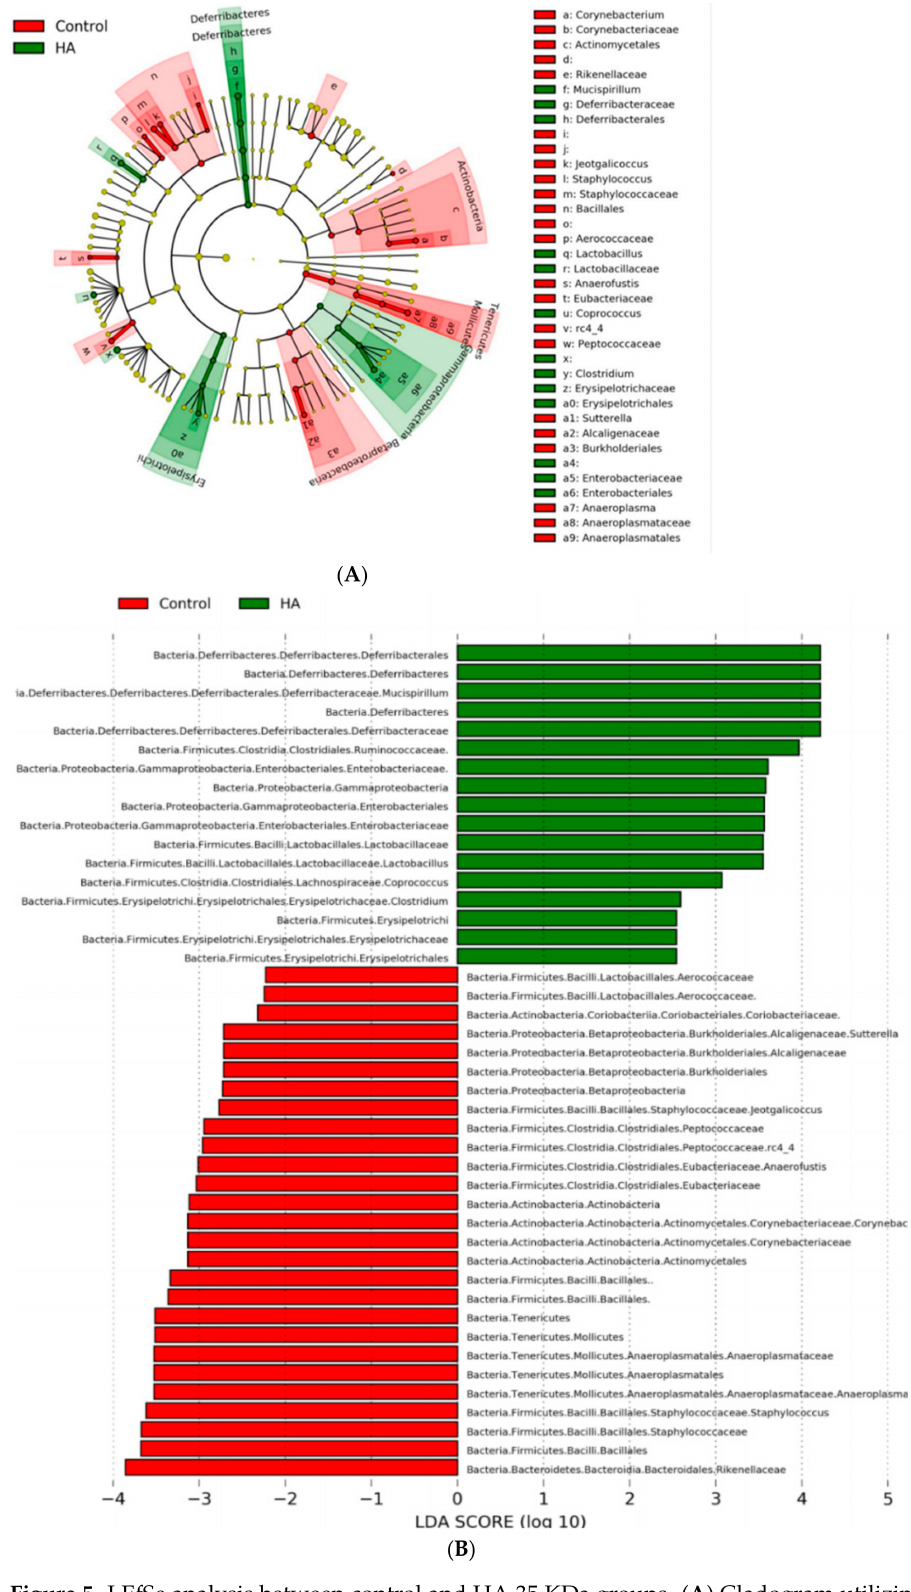
Figure 5. LEfSe analysis between control and HA 35 KDa groups. ( A ) Cladogram utilizing LEfSe indicates phylogenetic distribution of fecal microbes associated with control (green) and HA 35 KDa-treated (red) pups. ( B ) LDA scores of significantly different bacteria between control (red) and HA 35 KDa-treated (green) pups. HA: hyaluronic acid; LEfSe: linear discriminant analysis effect size; LDA: linear discriminant